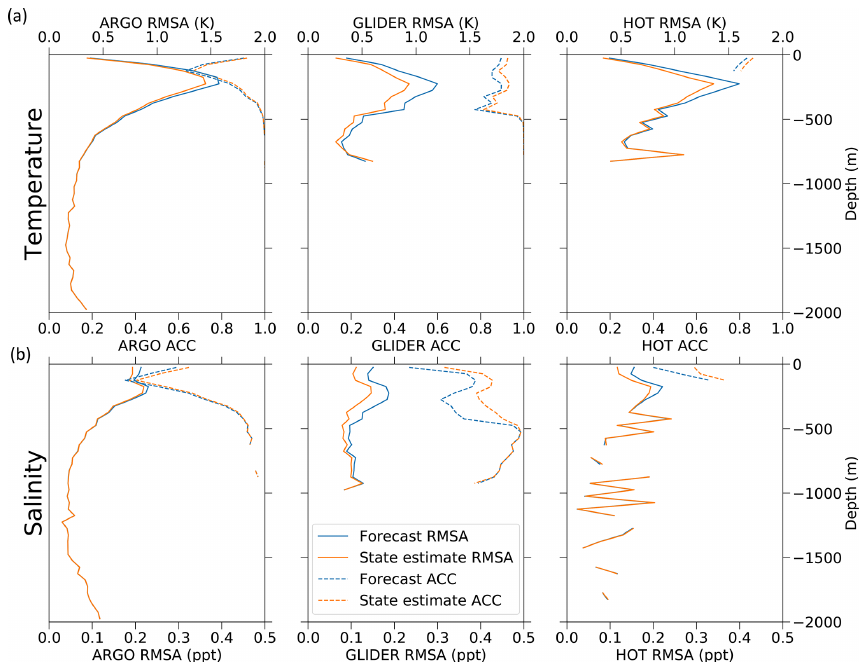
Figure 11. RMSA (solid) and ACC (dashed) profiles of subsurface temperature (a) and salinity (b) for Argo floats, Seagliders, and HOT CTDs for the forecast (blue) and the state estimate (orange). Data were binned into 50m